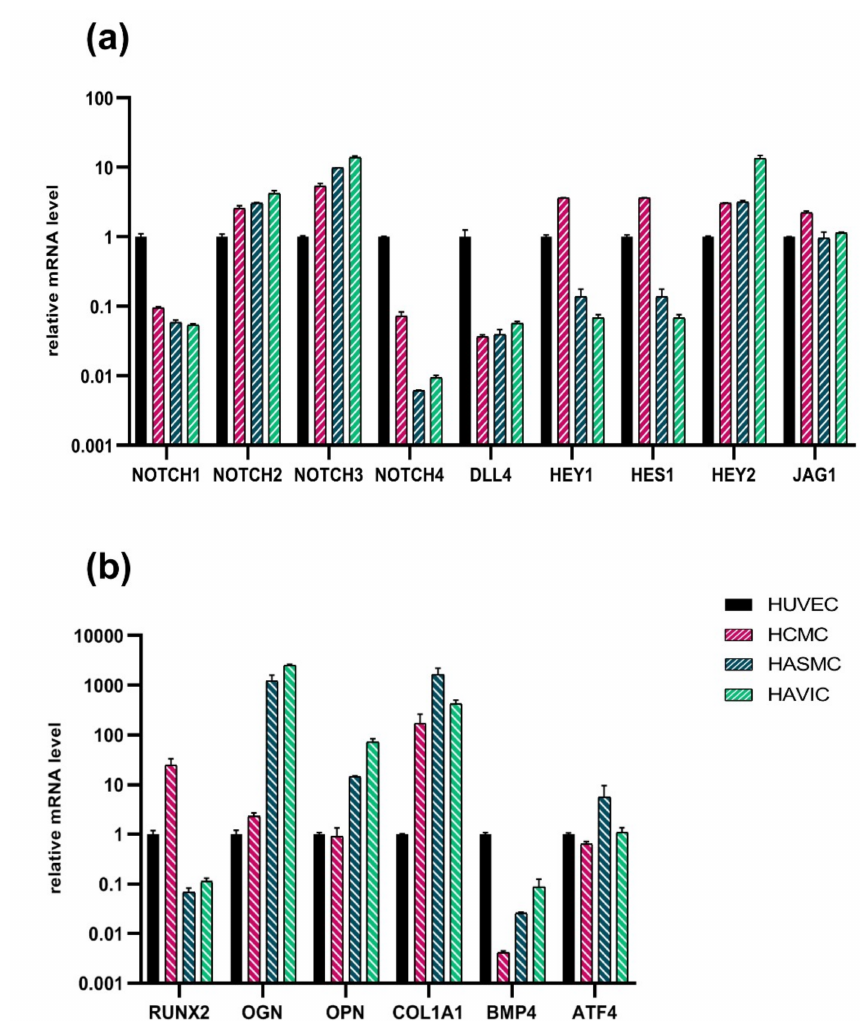
Figure 7. Comparison of Notch-related and proosteogenic gene expression between different cell lines of mesenchymal cells. ( a ) Analysis of Notch target gene expression by qPCR in undifferentiated cells. The results are represented as mean ± SD. A value of 1 was given to HUVEC mRNA levels for all genes (black). ( b ) Expression of osteogenic genes by qPCR in undifferentiated cells. Human umbilical vein endothelial cells (HUVEC), human cardiac mesenchymal cells (HCMC), human aortic smooth muscle cells (HASMC), and human aortic valve interstitial cells